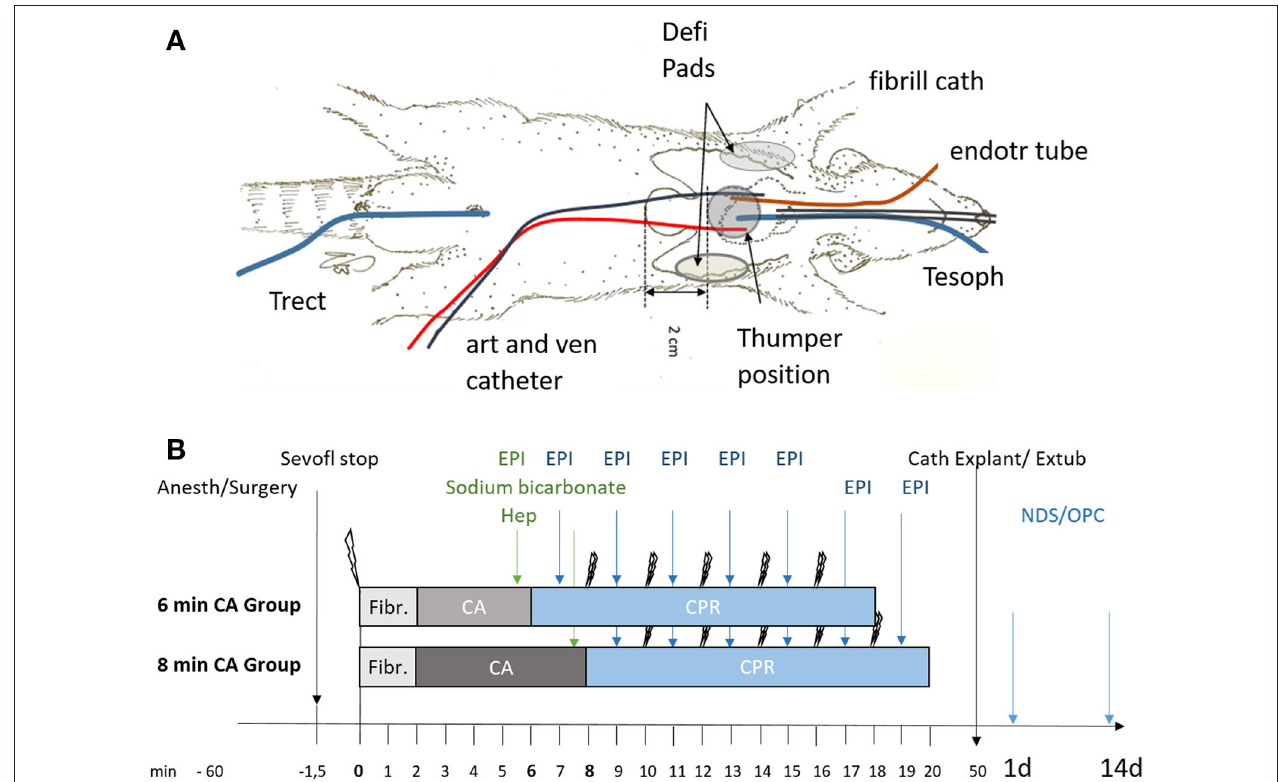
FIGURE 1 | Schematic representation of setup and timeline of the experiments. (A) Instrumentation of animals using an endotracheal tube (endotr tube), an arterial and venous catheter in the femoral artery and vein (art and ven catheter), an esophageal temperature probe (Tesoph), and a rectal temperature probe (Trect). Fibrillation catheter for inducing ventricular fibrillation (fibrill cath). For resuscitation defibrillation pads (Defi Pads) were placed as indicated and a thumper was positioned 2cm cranial of the xiphoid process. (B) Animals were randomly allocated to sham (not shown) or the 6 or 8min cardiac arrest (CA) group following anesthesia and surgery (Anesth/Surgery). Sevoflurane was stopped (Sevofl stop) and CA was induced by ventricular fibrillation (single lightning symbol; Fibr.). Heparin (Hep), epinephrine (EPI) and sodium bicarbonate were added prior to cardiopulmonary resuscitation (CPR) attempted by 2 consecutive defibrillation steps (double lightning bolts), repeated every 2min of CPR and followed immediately by epinephrine (EPI) supplementation every 2min of CPR. After successful resuscitation with maximal 5 defibrillation attempts catheters were explanted (Cath Explant) and animals extubated (Extub). Overall performance category score (OPC) and neurological deficit score (NDS) were determined in all surviving animals at day 1 and day 14 prior to